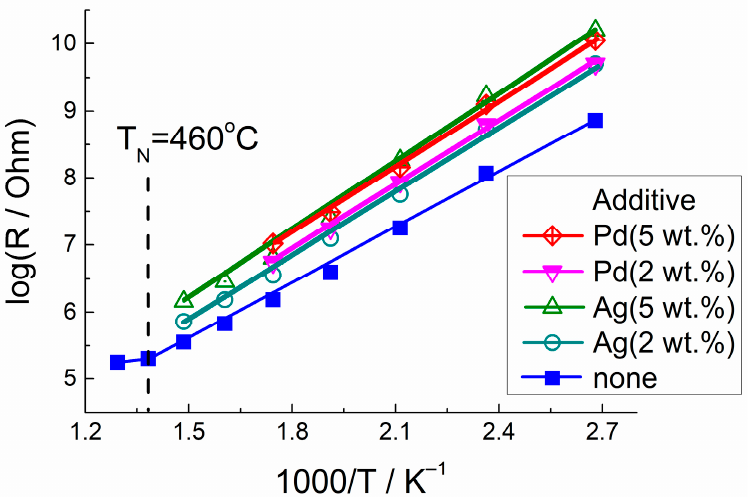
Figure 5. Logarithm of resistance of pristine and Ag- or Pd-modified LaFeO 3 in air in relation to inverse temperature. Table 3. Effective activation energy of conduction of LaFeO 3 at lower (T = 50–450 ◦ C) and higher (T = 450–500 ◦ C) temperature ranges and of Ag- and Pd-modified LaFeO 3 at tested temperatures (T = 50–400 ◦ C and T = 50–300 ◦ C, respectively).